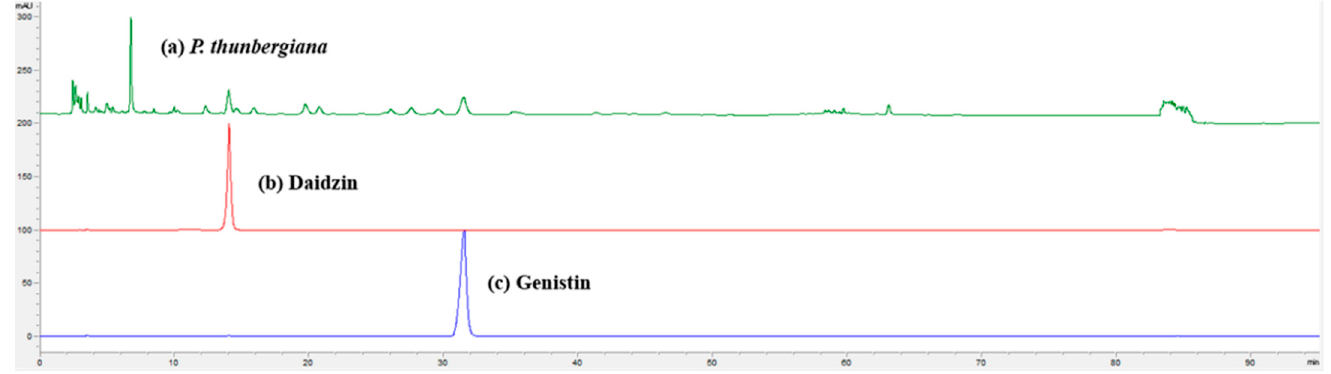
Figure 7. HPLC chromatogram shows peaks in extracts of P. thunbergiana EtOAc fraction, with absorbance evaluated at 254 nm. AU indicates the absorbance unit. (a) Daidzin standard, (b) genistin standard; (c) P. thunbergiana EtOAc fraction.